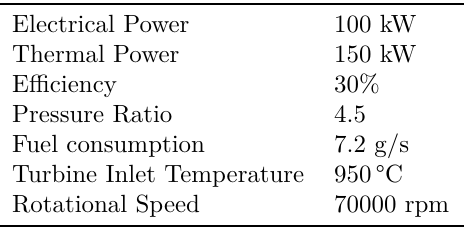
Table 1. Nominal performance of the T100 @ 15